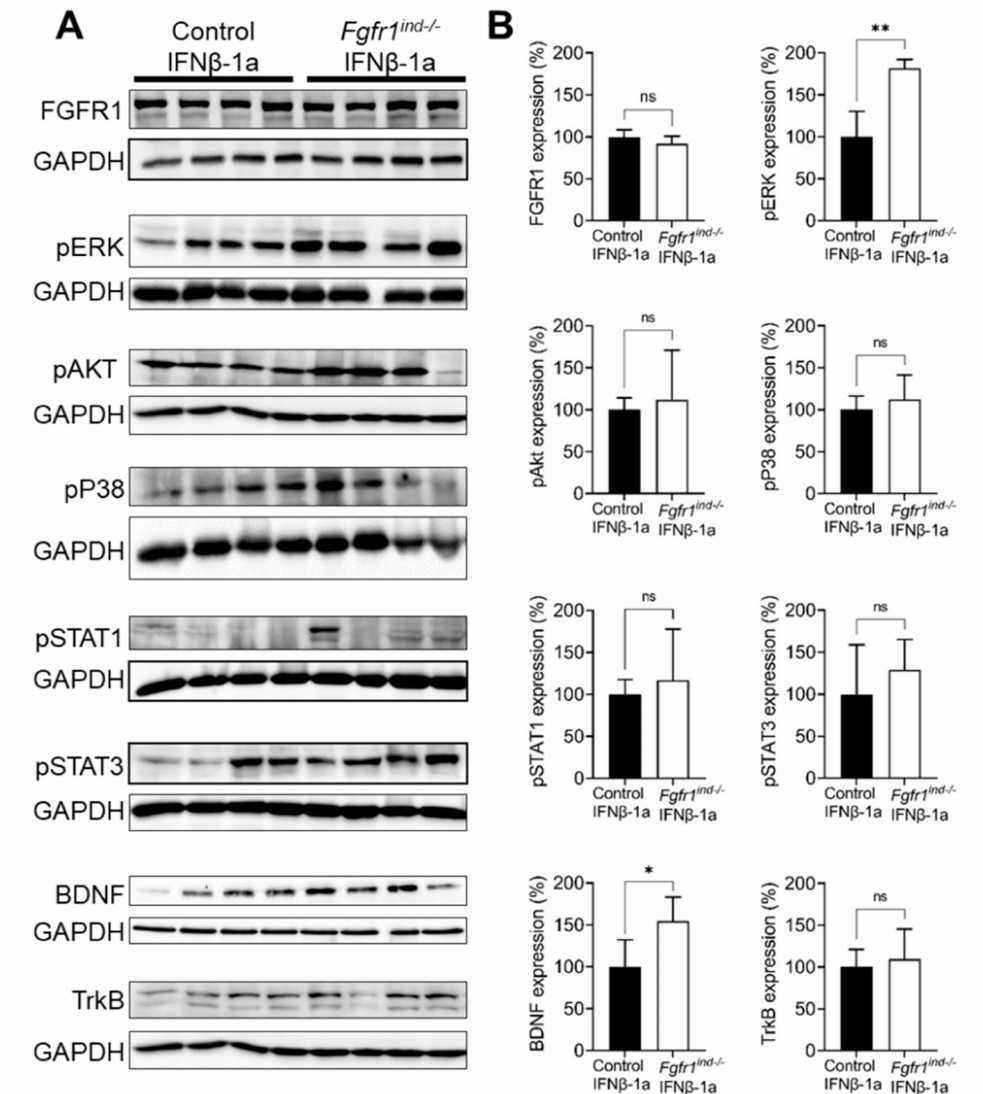
Figure 2. Protein expression of FGFR signaling and TrkB/BDNF in spinal cord lysates at day 62 p.i. ( A , B ). Protein expression of FGFR1, pAKT, pP38, pSTAT1/3, and TrkB were not different between IFN β -1a-treated controls and IFN β -1a-treated Fgfr1 ind − / − mice. The increased phosphorylation of ERK and increased BDNF protein expression was found in IFN β -1a-treated Fgfr1 ind − / − mice’s